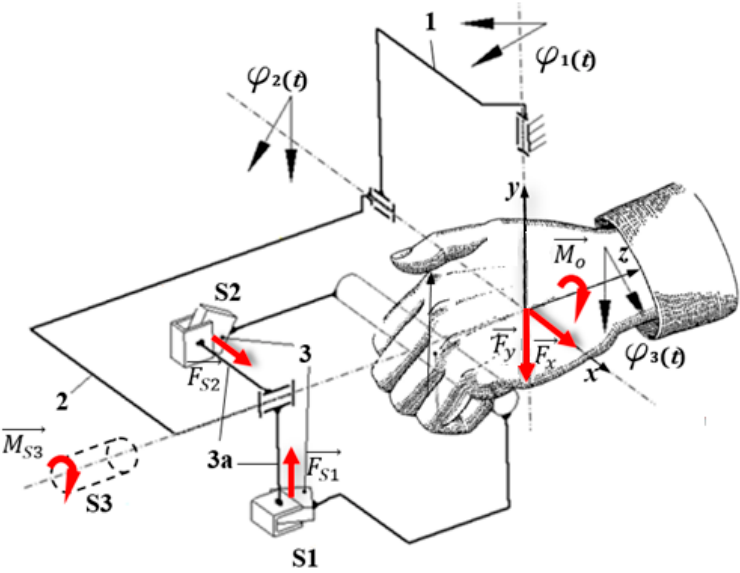
Figure 7. Sensory grip for the MWR mechatronic device—kinematic scheme.